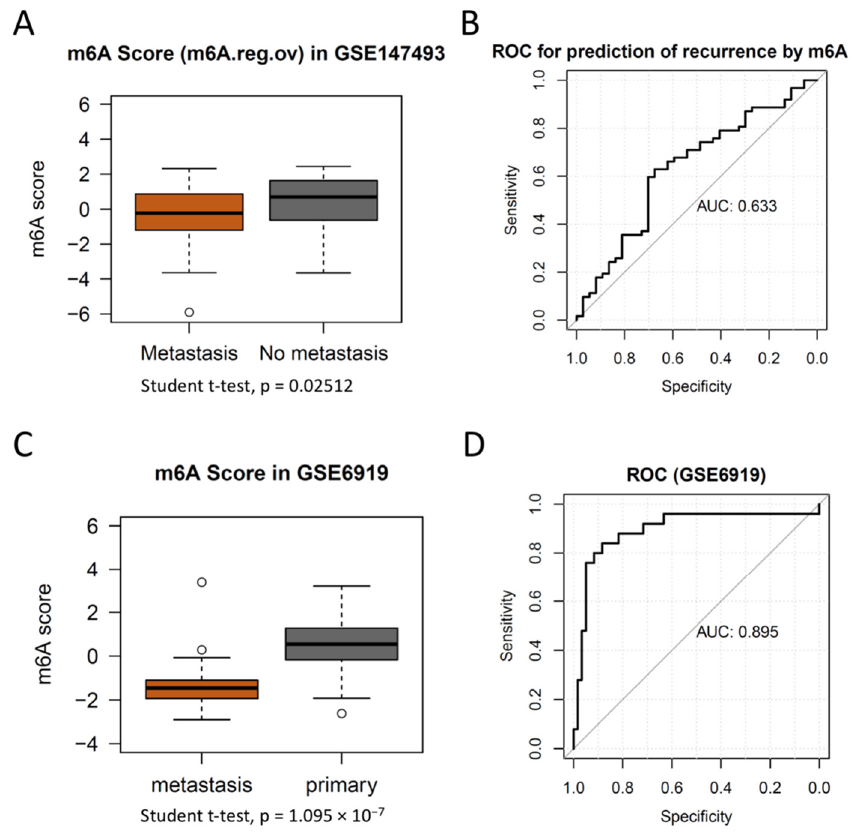
Figure 5. The m 6 A regulators are differentially expressed between metastatic and non-metastatic PCas. ( A ) Boxplot showing metastatic PCa has a significantly lower m 6 A score. Student t test, p = 0.02512. ( B ) The m 6 A score showed a moderate discrimination of metastatic PCa from non-metastasis. The accuracy of the m 6 A score is determined by the Area Under the Curve (AUC). The effectiveness of the m 6 A score is validated in another independent cohort (GSE6919). The boxplot ( C ) showing the metastatic PCa has a significantly lower expression of m 6 A score than primary PCa. ( D ) ROC of the GSE6919 dataset demonstrating the prediction accuracy for metastatic PCa is 89.5% in the validation